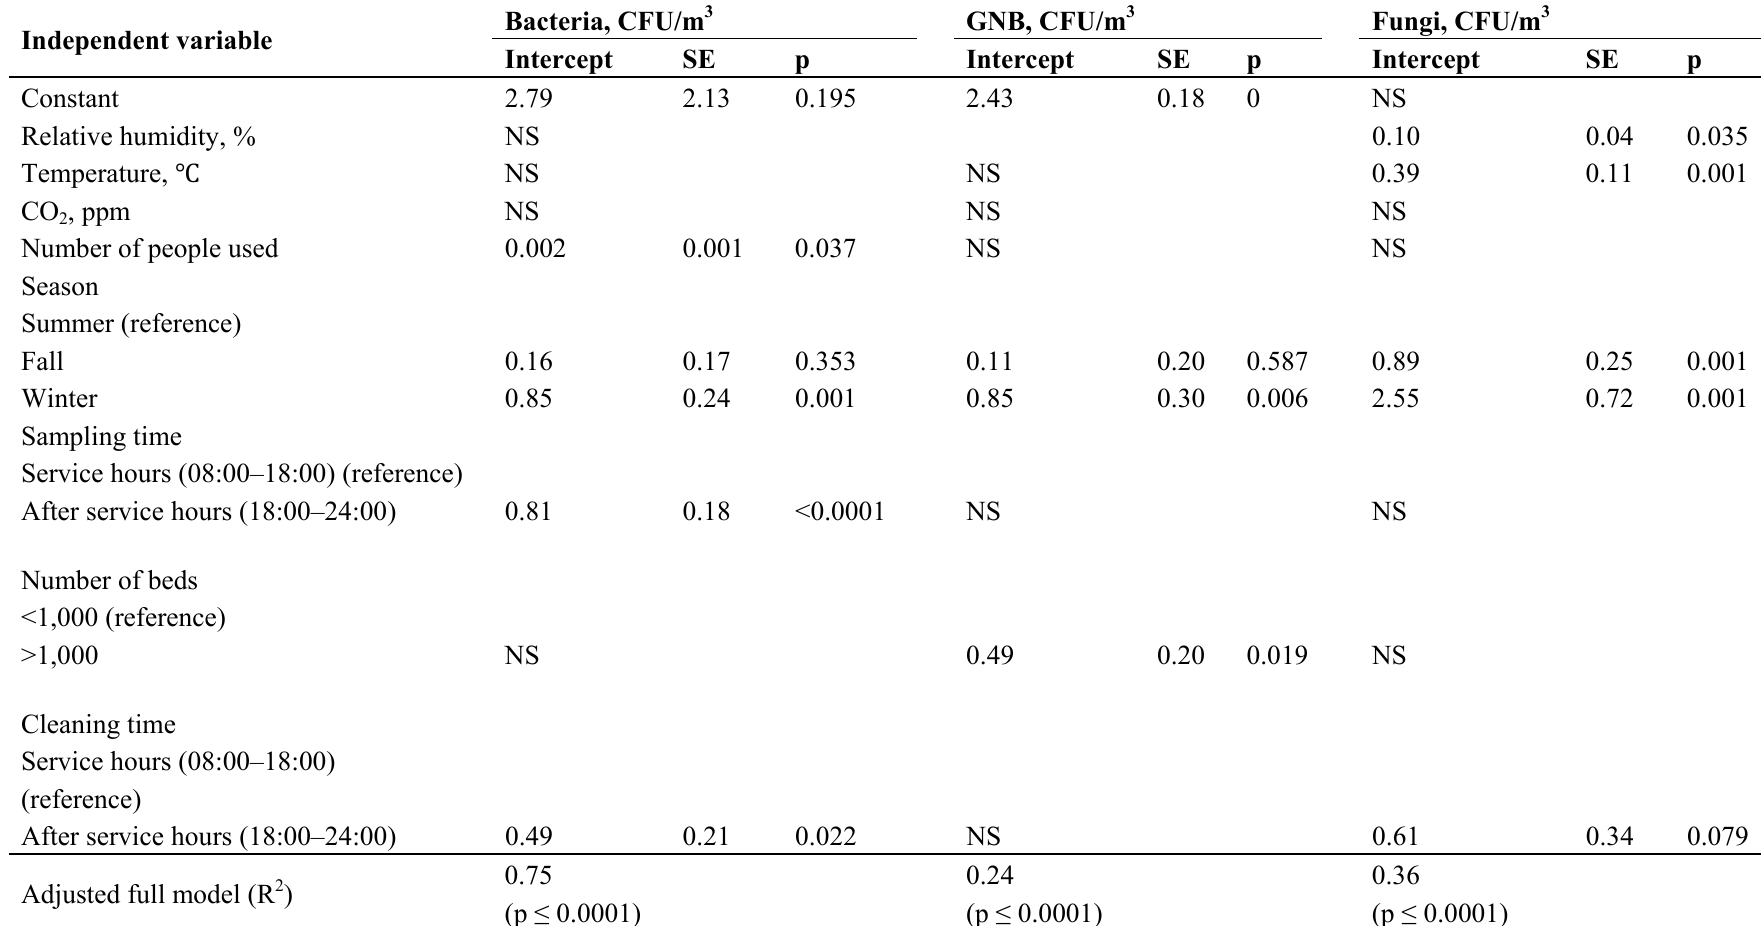
Table 7. Multiple regression models for predicting the log-transformed levels of bacteria and GNB in a hospital lobby Bacteria, CFU/m 3 GNB, CFU/m 3 Fungi, CFU/m Independent variable